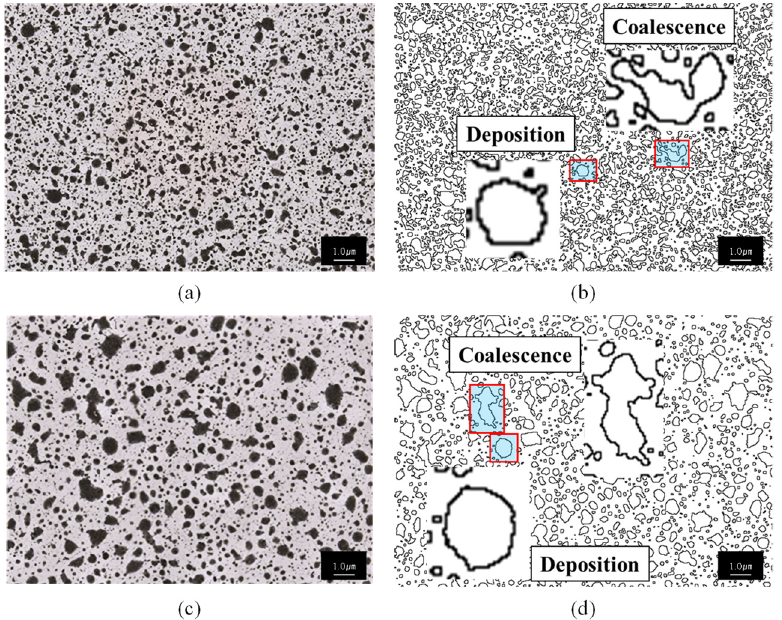
Figure 3. Effect of nozzle diameter on atomized ink droplet figures and clustering shape (deposition and coalescence). The 0.4 Ø nozzle is shown in ( a ) and ( b ), the 0.7 Ø nozzle in ( c ) and ( d ).